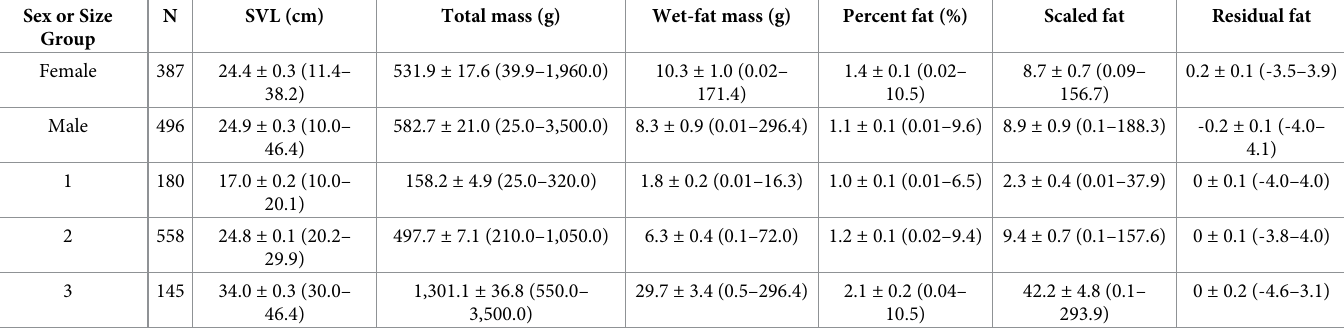
Table 2. Summary of morphometric and fat measurements from Argentine black and white tegus included in this study. Values are expressed as mean ± standard error (range). Size groups (1, 2, and 3) were defined based on the fitted segmented regression model (Fig 2), which defined size groups as hatchlings to early juveniles (group 1, < 20.2 cm SVL), late juveniles to reproductive-sized adults (group 2, 20.2 cm to 30.0 cm SVL) and large adults (group 3, > 30.0 cm SVL). Sex or Size Group